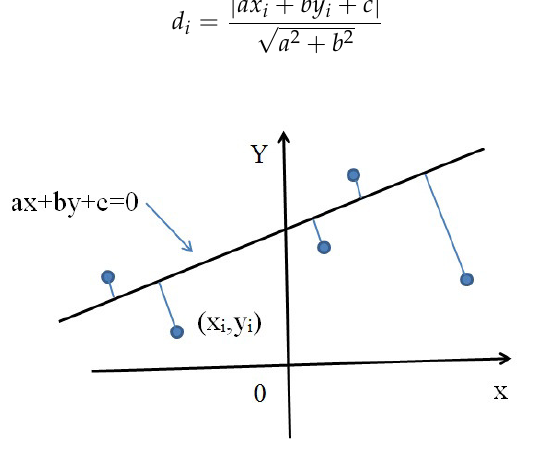
Figure 6. Straight line